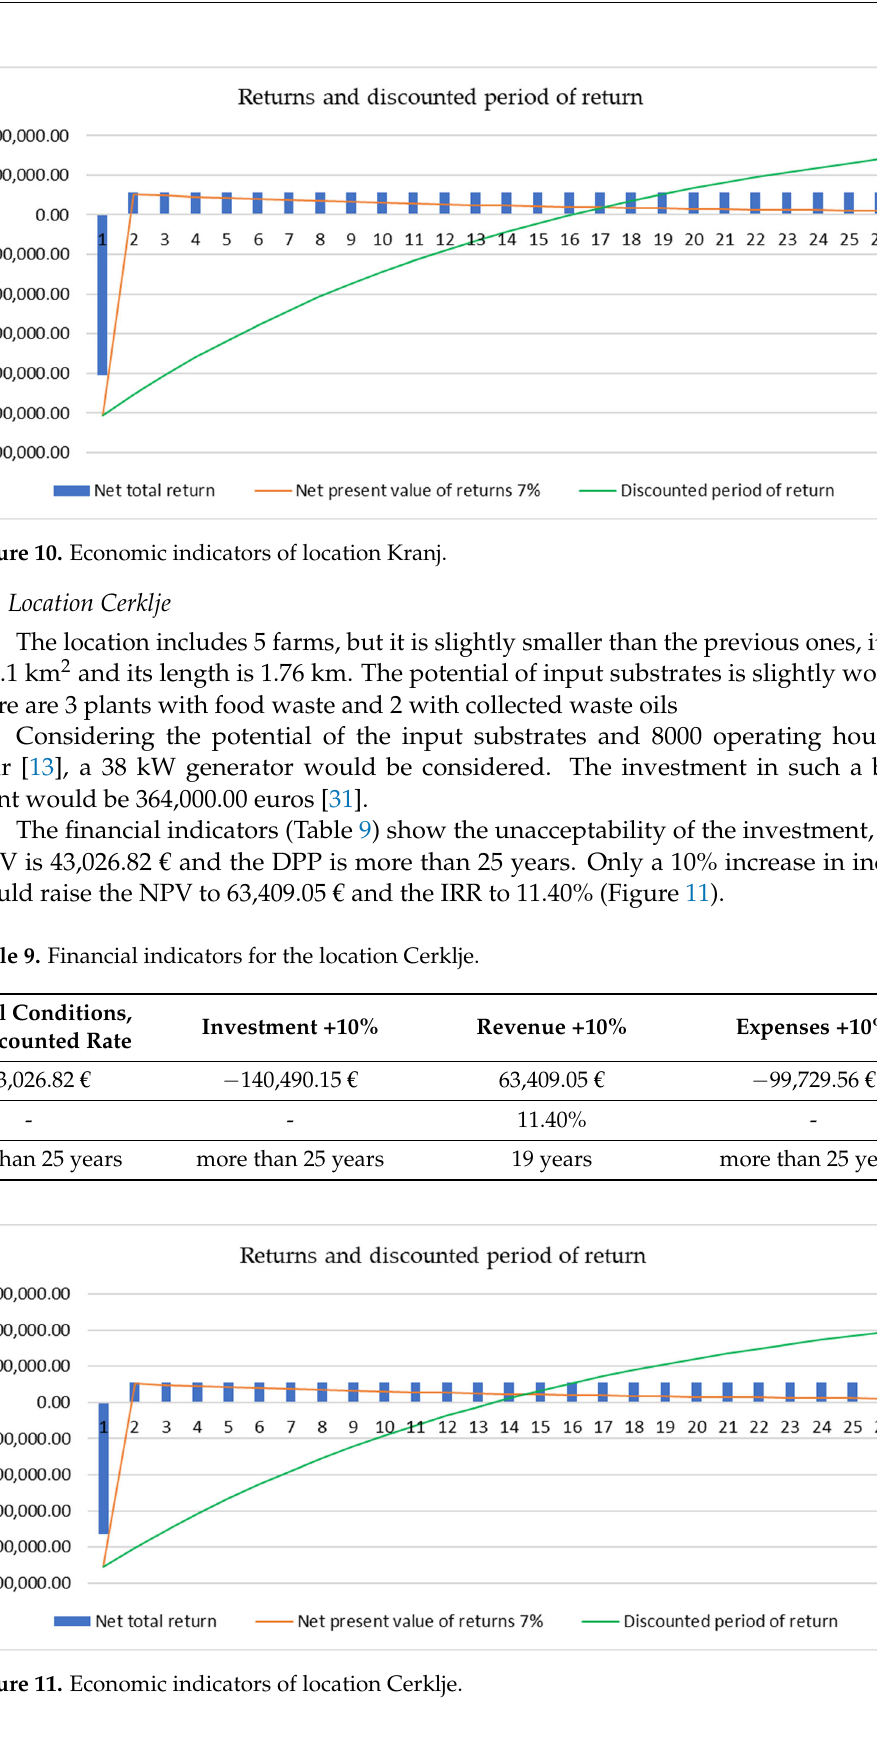
Table 10. Different scenarios of adding corn silage for location Cerklje.